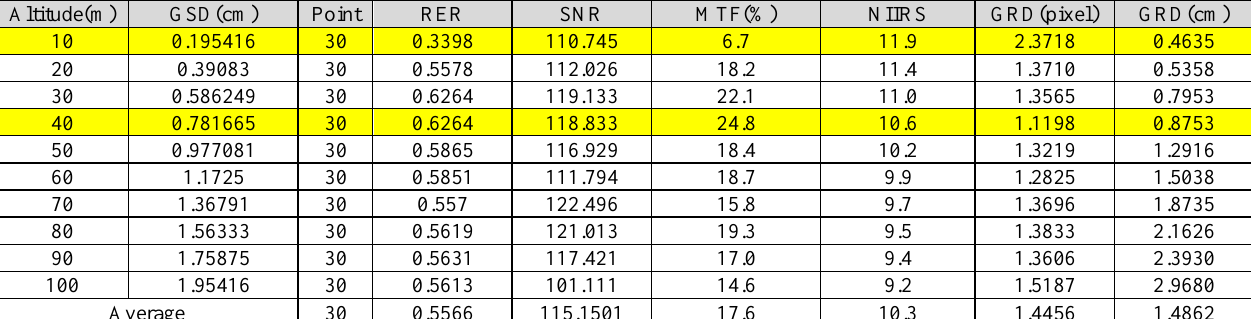
Table 5. Image quality parameters in the Second drone shot images